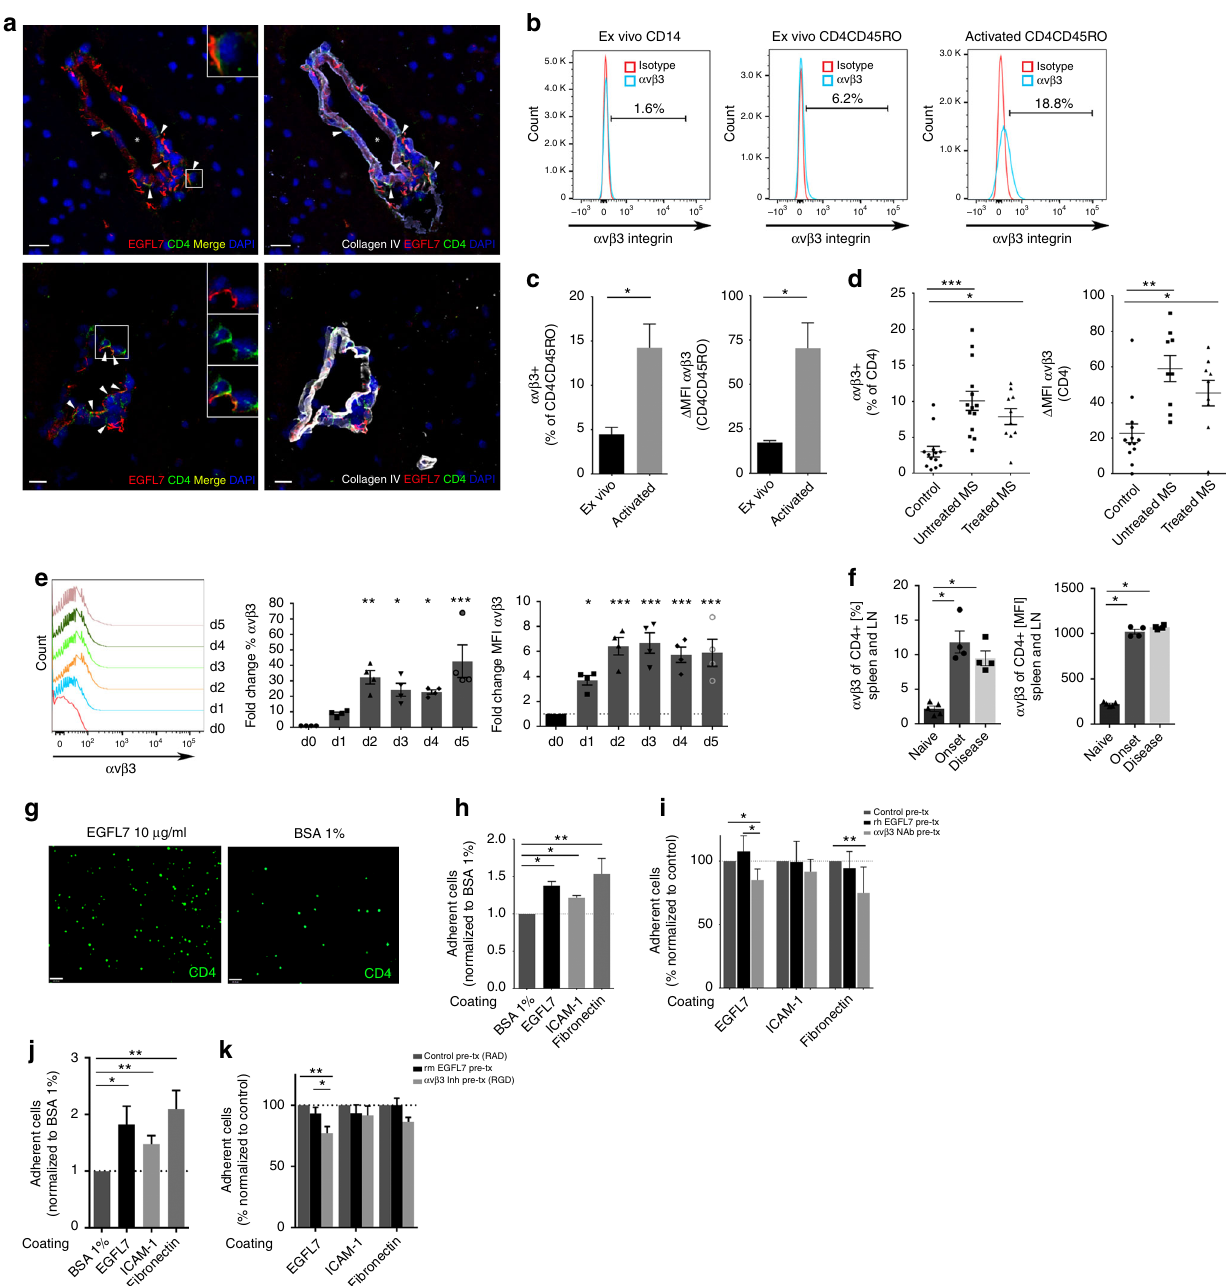
Fig. 2 T lymphocytes express ligand α v β 3 integrin and adhere to EGFL7. a Colocalization of CD4 + cells (green) and EGFL7 (red) in perivascular ECM area in MS brain lesions (upper panel = frontal, lower panel = temporal). Collagen IV = white. Nuclei (DAPI) = blue. Representative of n = 4 MS donors, ≥ 3 lesions/donor. b Expression of α v β 3 integrin on human CD14 monocytes ex vivo (left), memory CD4 T lymphocytes ex vivo (center), and in vitro activated memory CD4 T lymphocytes (right), as assessed by fl ow cytometry. Representative of n = 6 donors. c Expression of α v β 3 integrin on human CD4 T lymphocytes ex vivo and upon activation. Percentage and mean fl uorescence intensity (MFI). n = 6 donors. d Expression of α v β 3 integrin on human CD4 T lymphocytes ex vivo from healthy controls, untreated MS or treated MS. Flow cytometry analysis. 1 dot = 1 donor. e , f Expression of α v β 3 integrin by murine CD4 T lymphocytes ( e ) ex vivo and on day 1 – 5 in vitro upon activation, and ( f ) in naïve and MOG 35 – 55 -immunized (EAE) mice at different time points of EAE. n = 4 – 5 mice/condition, 1 dot = 1 mouse. g – k Adhesion assay. g Representative microscopy images of CFSE-labeled activated human CD4 T lymphocytes adhering to rhEGFL7 or BSA 1% after 24 h. Scale bar = 100 μ m. Amount of human ( h ) and murine ( j ) activated CFSE-labeled CD4 T cells adhering to coated rh or rmEGFL7, ICAM-1 or fi bronectin, normalized to BSA 1%, according to fl uorescence intensity as assessed by plate-reader. n = 6 human donors and n = 8 mice. Amount of human ( i ) and murine ( k ) cells adhering to coated EGFL7, ICAM-1 or fi bronectin, following pre-treatment with rhEGFL7 ( i ) or rmEGFL7 ( k ); anti- α v β 3 integrin neutralizing antibody ( i ) or RGD-peptide ( k ); or relevant control (rat serum, isotype or RAD-peptide). n = 7 human donors and n = 8 mice. Statistical analysis performed by Wilcoxon matched-pairs signed rank test ( c ) and one-way ANOVA followed by Tukey ’ s multiple comparison test ( d – k ). * p < 0.05, ** p < 0.01, *** p < 0.001. All data presented as mean ±